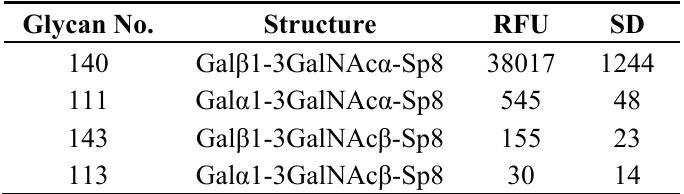
Table 5. Binding affinity of SSR2 towards different anomeric forms of TF disaccharides. Glycan